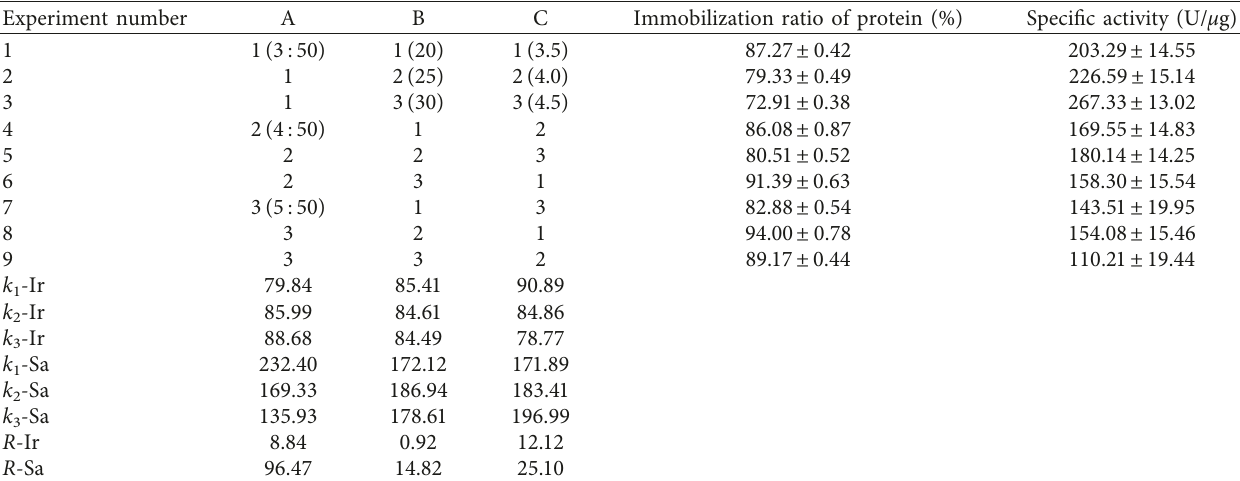
Table 2: Orthogonal experimental results and analysis.